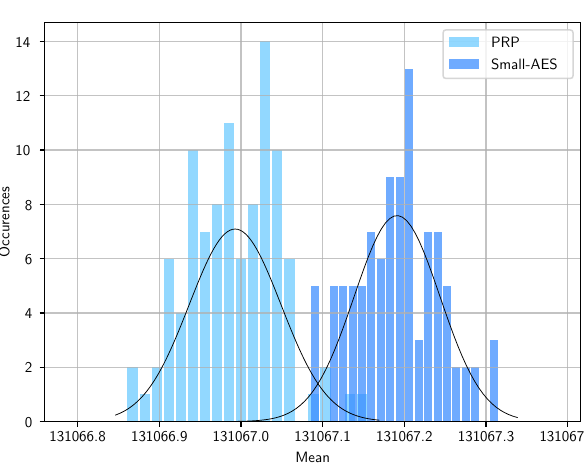
Figure 8: Distribution of the means ( µ ) and fitted normals from 100 experiments that counted the number of collisions in at least one ciphertext column per structure of 2 16 texts of our six-round distinguisher on Small- AES and full Speck-64 as pseudorandom permutation π . σ ∗ is the observed standard deviation of the means per structure among the 100